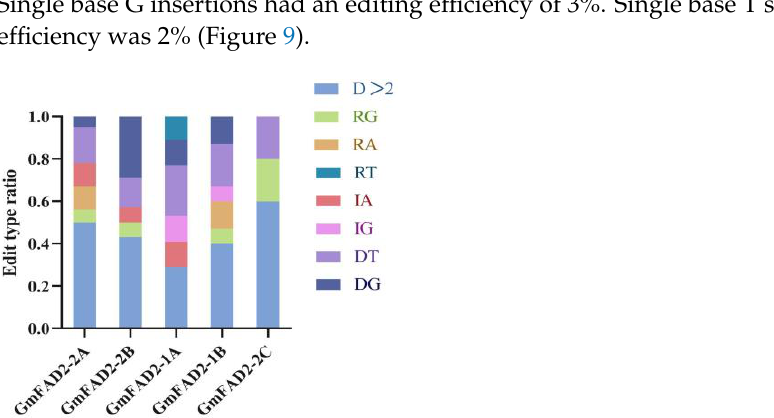
Figure 8. Partial prediction diagram of protein tertiary structure: ( a ) wild; ( b ) FAD2-1A mutant; ( c ) FAD2-1B mutant; ( d ) FAD2-2A mutant; ( e ) FAD2-2B mutant; ( f ) FAD2-2C mutant.